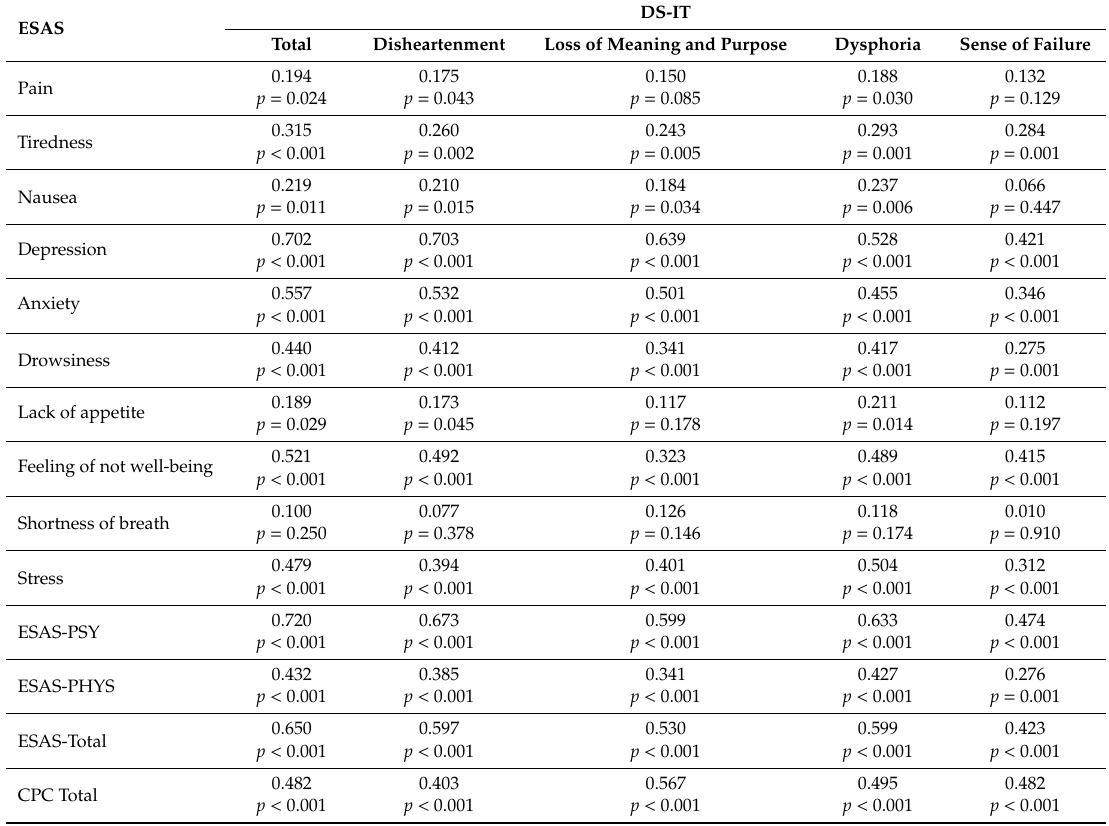
Table 7. Correlation between DS-IT and scores of